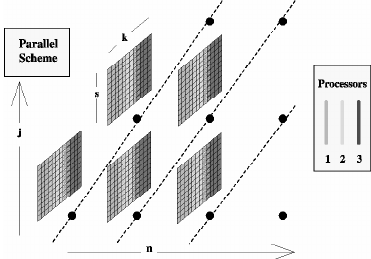
Figure 3. Schematic representation of the computing load of the numerical al- gorithm.